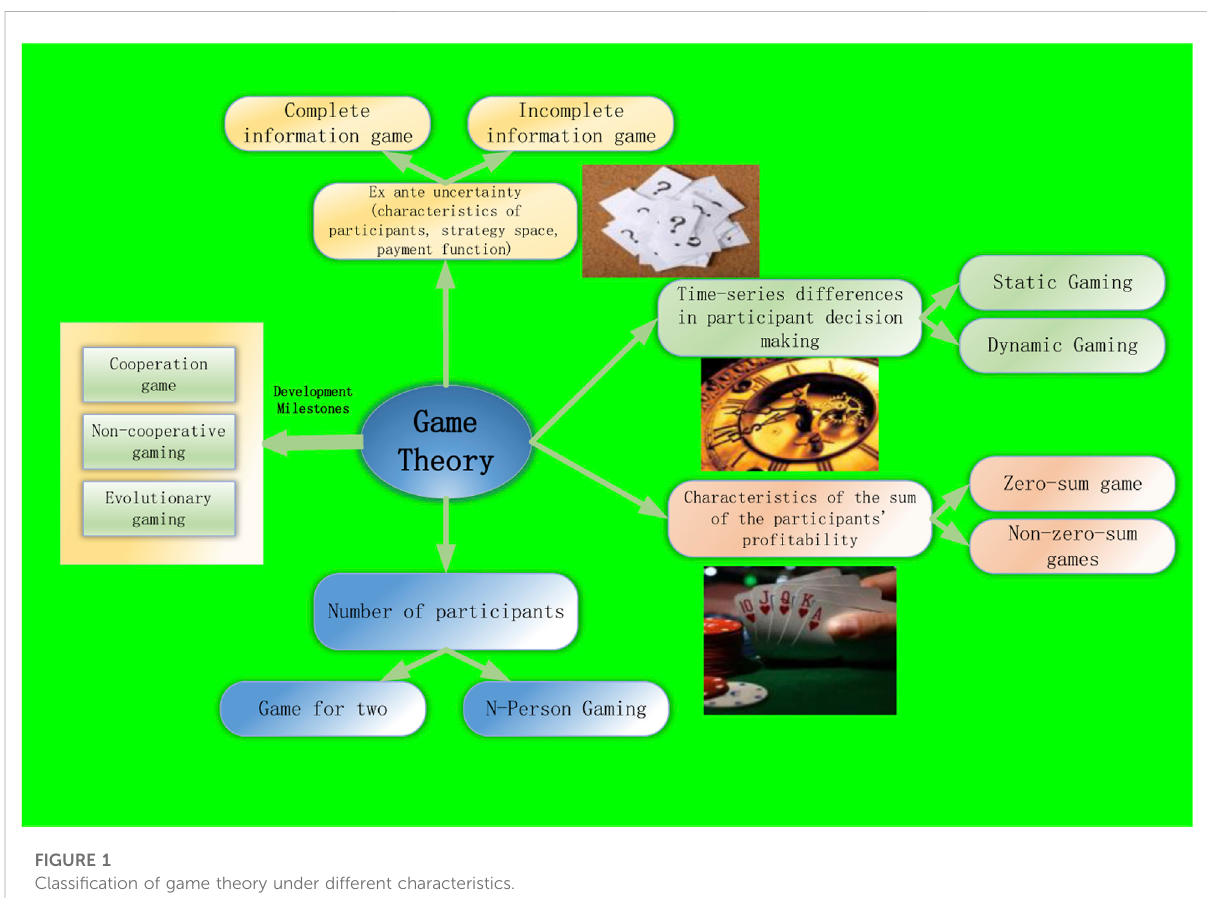
FIGURE 1 Classi fi cation of game theory under different